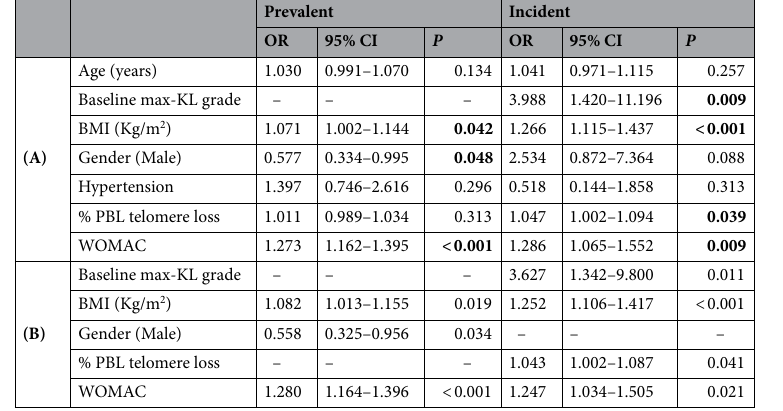
Table 3. Prevalent and incident radiographic knee OA: (A) Multivariable analysis using logistic regression analysis to evaluate the association of variables with prevalent and incident knee osteoarthritis. (B) Logistic regression model with selected variables. Significance was defined as p < 0.05.